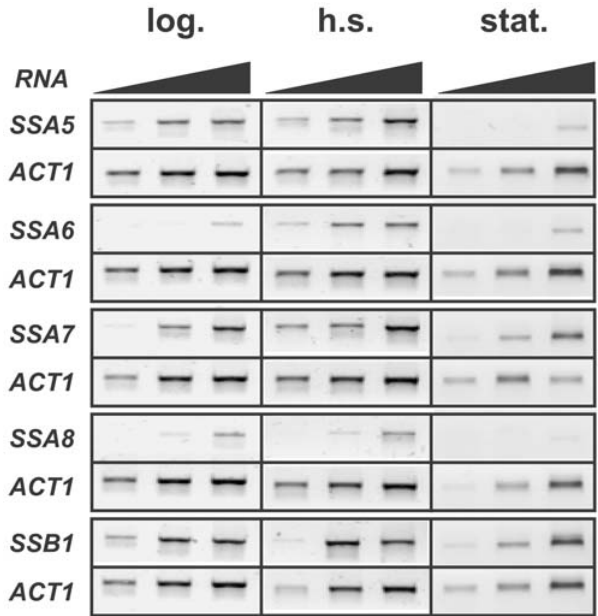
Figure 1. RT-PCR analysis of Hsp70 isoforms expression in Yarrowia lipolytica . Total RNA was isolated from a wild-type Y. lipolytica strain grown to early exponential phase at 28 u C (left panel), followed by one hour shift at 42 u C (middle panel) or left to grow to stationary phase (right panel). The expression of each Hsp70 ortholog was assessed by RT-PCR analysis (using 1, 10 or 100ng of RNA) as described in Materials and Methods using the ACT1 gene as a loading control.